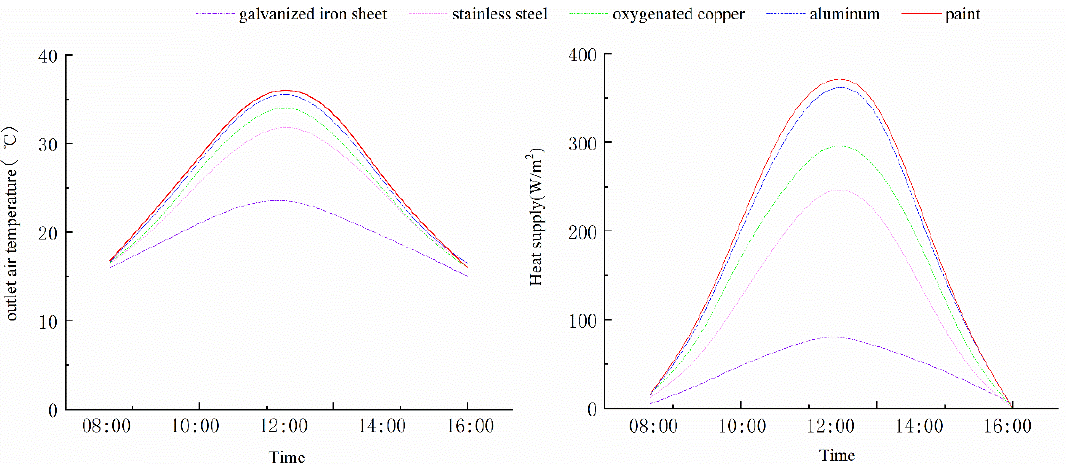
Figure 14. Effect of fin material on outlet temperature and heat gain of the solar wall.